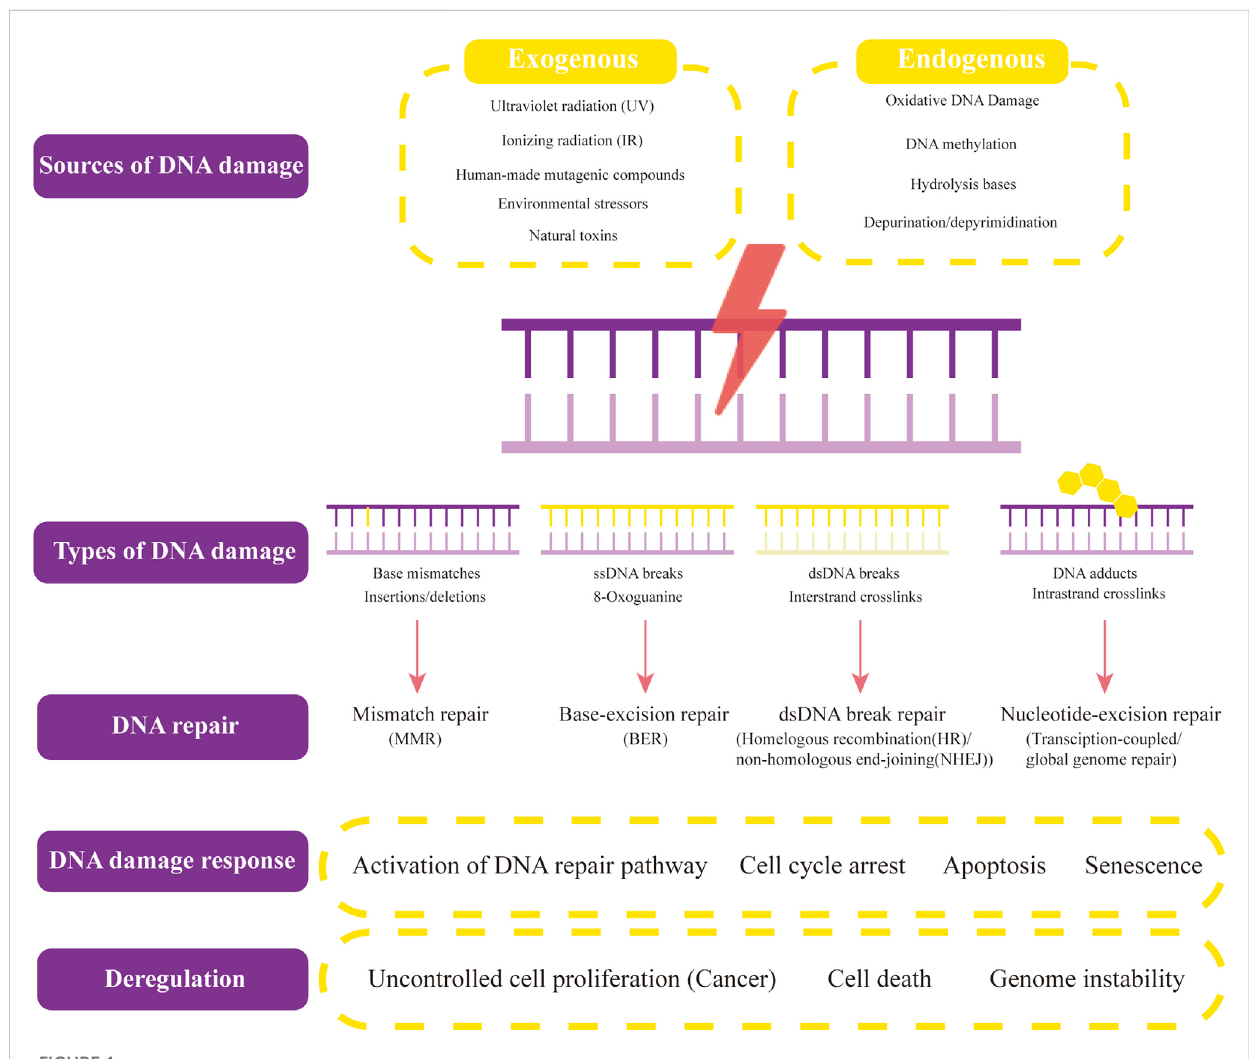
FIGURE 1 Sources and types of DNA damage and DNA repair. Both exogenous factors and endogenous factors can cause DNA damage. Exogenous factors contain ultraviolet radiation, ionizing radiation, human-made mutageniccompounds, environmental stressors, and other natural toxins. Endogenous biological activities can damage DNA in many ways, including oxidative DNA Damage, DNA methylation, hydrolysis of bases, and depurination/ depyrimidination. The common types of DNA damage include base mismatches (insertions/deletions), ssDNA breaks (8-Oxoguanine), dsDNA breaks (Interstrand crosslinks), and DNA adducts (intrastrand crosslinks). Their corresponding DNA repair methods are mismatch repair (MMR), base- excision repair (BER)/non-homologous end-joining (NHEJ), and transcription-coupled/global genome repair. When different types of DNA lesions activate DNA-damage response proteins, DNA repair begins. The signaling pathways that these proteins then activate include those for DNA repair, cell cycle arrest, apoptosis, and senescence. Uncontrolled cell proliferation (cancers), cell death, and genome instability result from dysregulation of DNA damage response and repair, and several of these proteins offer potential therapeutic